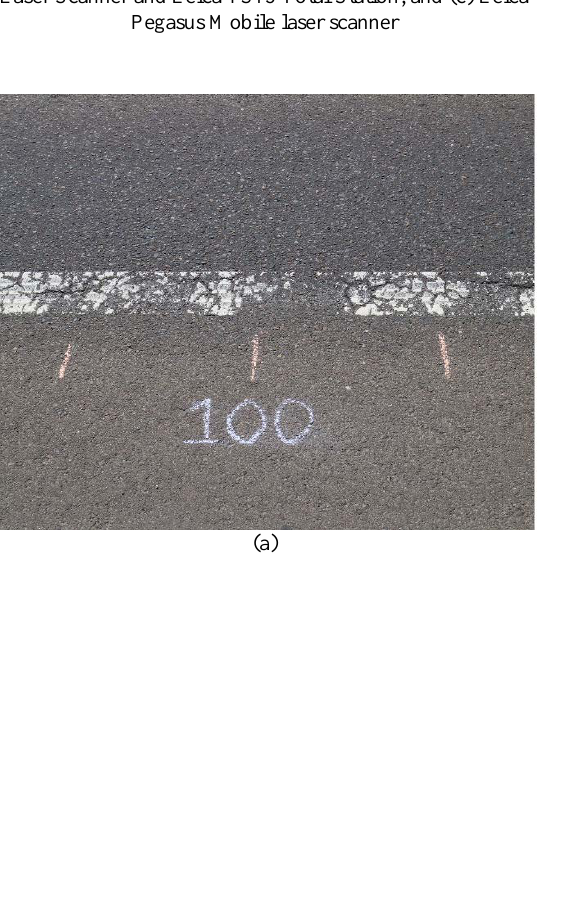
Figure 2. Examples of field data acquisition including (a) handheld retroreflectomer, (b) Leica ScanStation P40 Terrestrial Laser Scanner and Leica TS15 Total Station, and (c) Leica Pegasus Mobile laser scanner